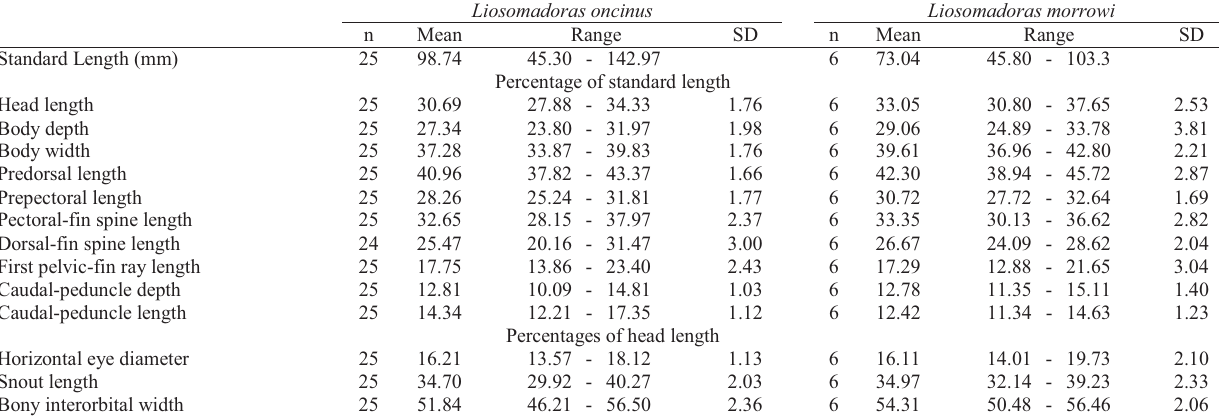
Table 1. Morphometric data for Liosomadoras oncinus and L. morrowi . n = number of analized specimens; SD = Standard